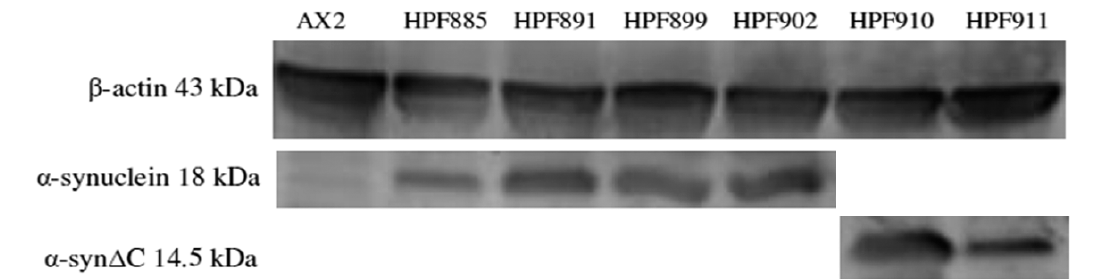
Figure 1. Human α -synuclein can be expressed in D. discoideum. Western blot showing the expression of α -synuclein WT HPF885 (38) and HPF891(96), α -synuclein A53T HPF899 (88) and HPF902(26) which runs at 18 kDa and α -synuclein ∆ C HPF910 (57) and HPF911(53) which runs at 14.5 kDa. The numbers in brackets represent construct copy numbers. B-actin was detected as an indicator of sample load. The parental strain AX2 was run as a negative